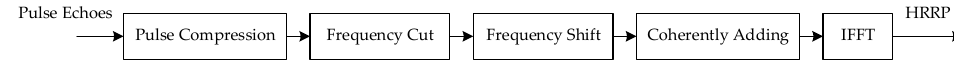
Figure 1. Flowchart of frequency-domain stepped-frequency processing method.